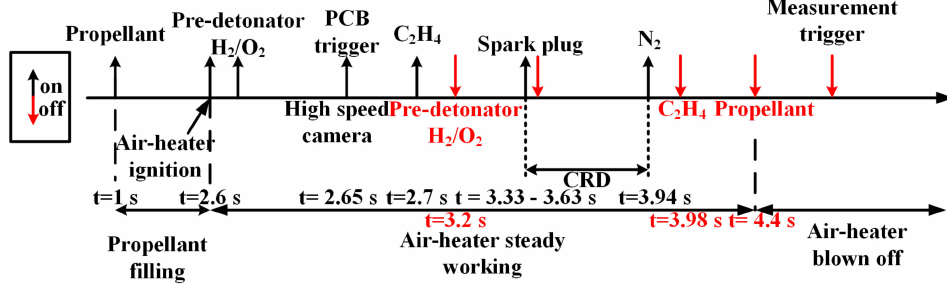
Figure 3. Time sequence of the CRD